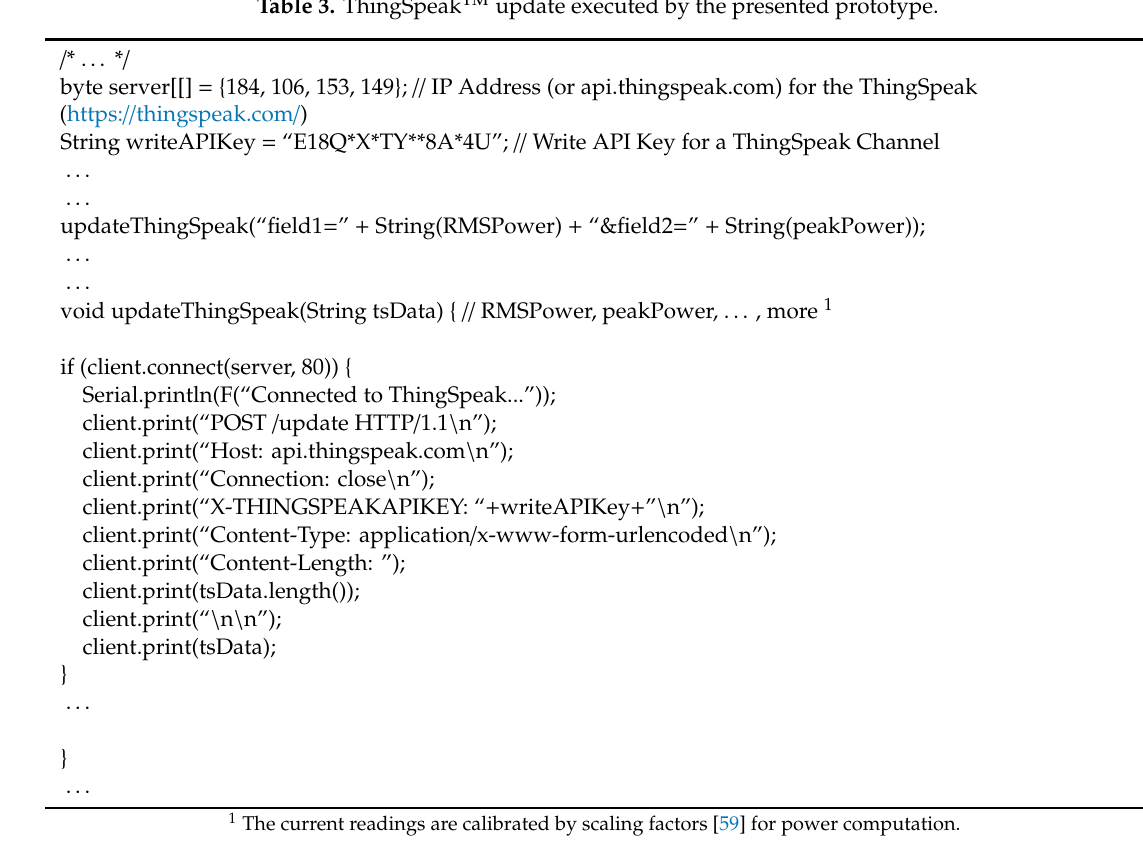
Table 3. ThingSpeak TM update executed by the presented prototype.